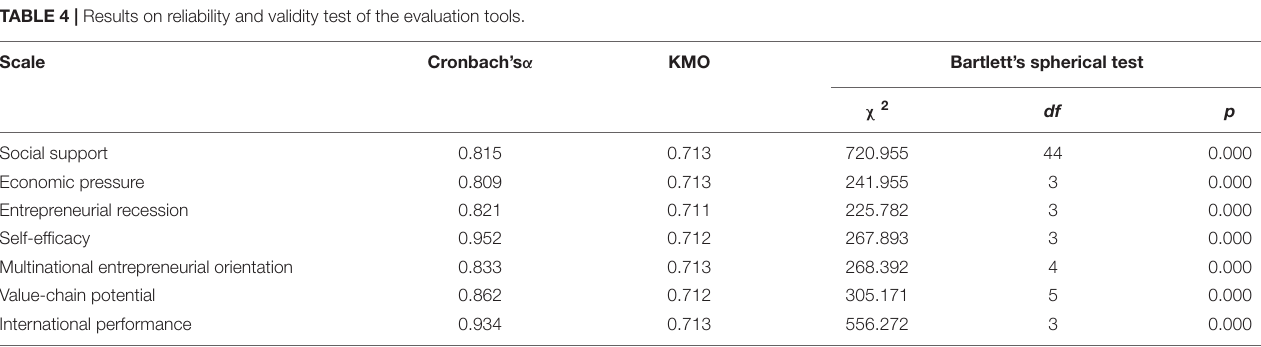
FIGURE 6 | Statistical results of basic data of the subjects [Figure (A) is the sex ratio; Figure (B) is the age range; and Figure (C) is the academic qualification]. TABLE 4 | Results on reliability and validity test of the evaluation tools.